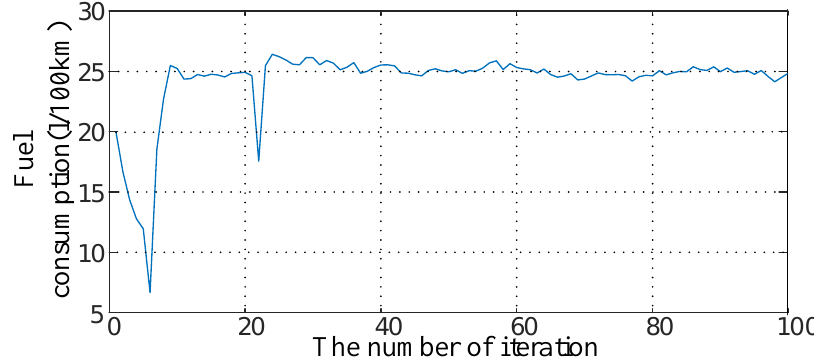
Figure 13. The equivalent fuel consumption variation with different iterations.